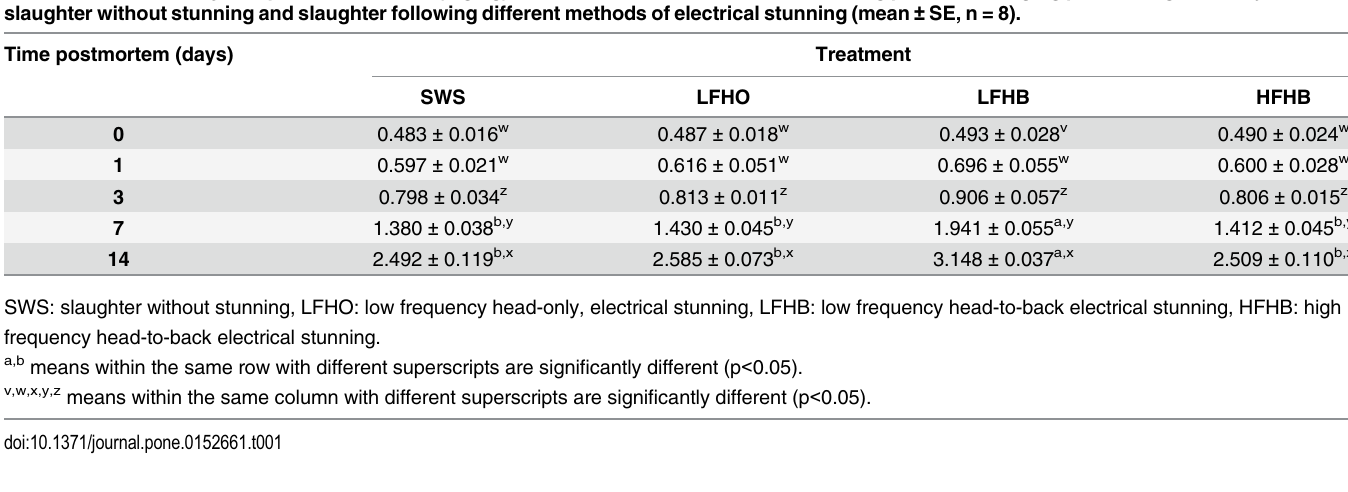
Table 1. Malondialdehyde equivalents content (mg/kg) of longissimus lumborum muscle during postmortem aging periods in goats subjected to slaughter without stunning and slaughter following different methods of electrical stunning (mean ± SE, n = 8). Time postmortem (days)